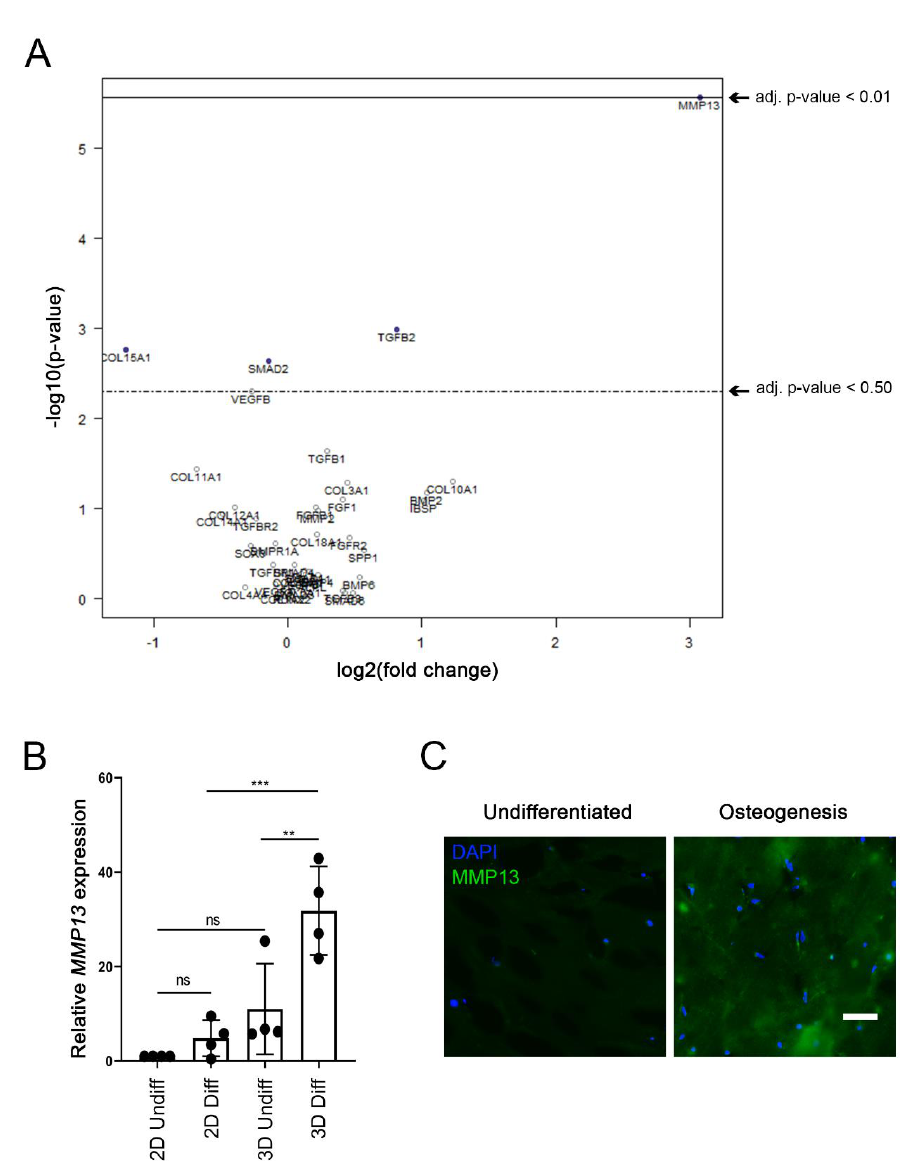
Figure 5. Enhanced MMP13 gene expression and production due to 3D osteogenic differentiation. ( A ) Multivariate analysis of the sixty-six tested genes (NanoString ® kit) displayed as a volcano plot (created with nSolver ® software) with the 2D or 3D condition set as covariate. The plot shows each gene’s -log 10 ( p -value) and log 2 fold change associated to the 2D or 3D condition. Highly statistically significant genes fall at the top of the plot above the indicated p -value lines, and highly differentially expressed genes fall to either side (right = upregulated, left = downregulated). The only significantly ( p -value < 0.01) affected gene that was upregulated was MMP13. ( B ) Relative gene expression of MMP13 is shown in the four various conditions: 2D undifferentiated, 2D differentiated, 3D undifferentiated, 3D differentiated, after 5 weeks of culture. The significance levels for relative gene expression difference are indicated as ** ( p -value < 0.01), *** ( p -value < 0.001). ( C ) Immunohistochemistry of 5-week undifferentiated vs. differentiated (osteogenic) 3D Col I gels against MMP13 and nuclear DAPI. Scale bar = 50 μm.